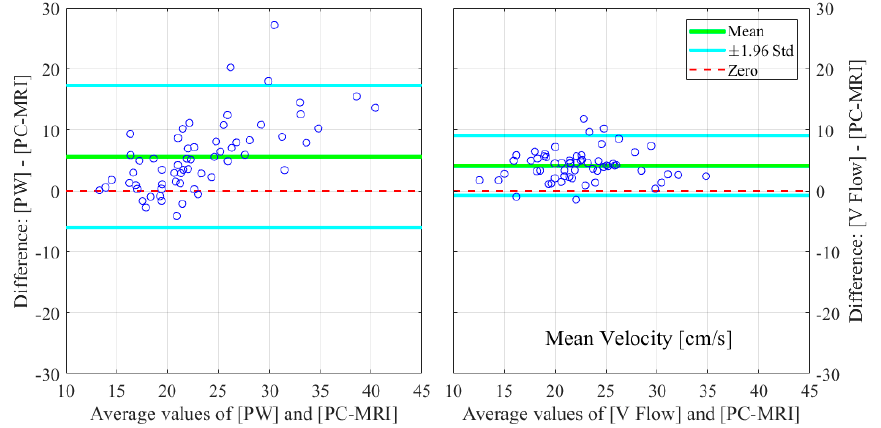
Figure 8. Bland–Altman plots for illustrating the differences in the estimated mean velocities for PW and V Flow relative to PC-MRI.